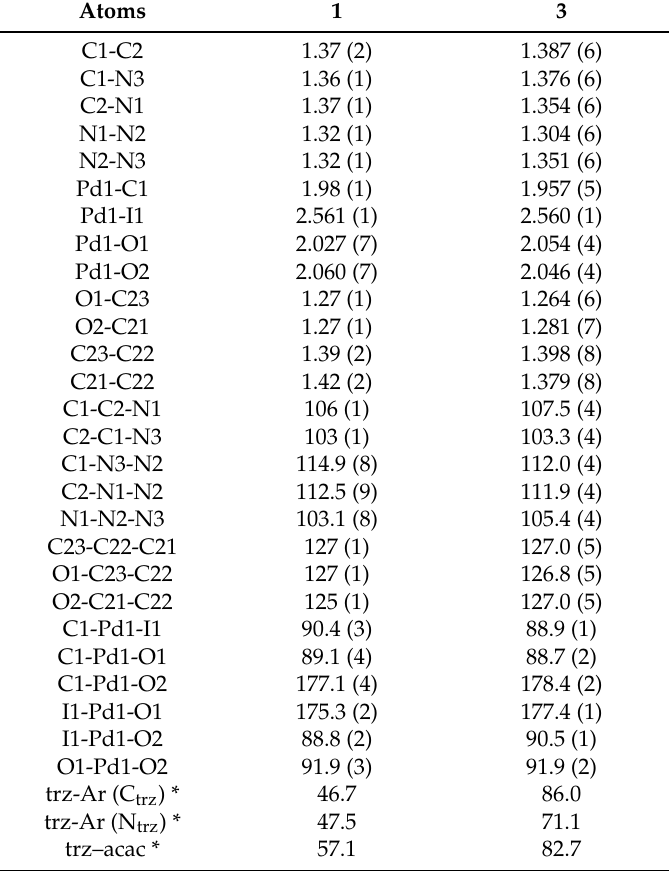
Table 1. Selected bond length (Å) and angles ( ◦